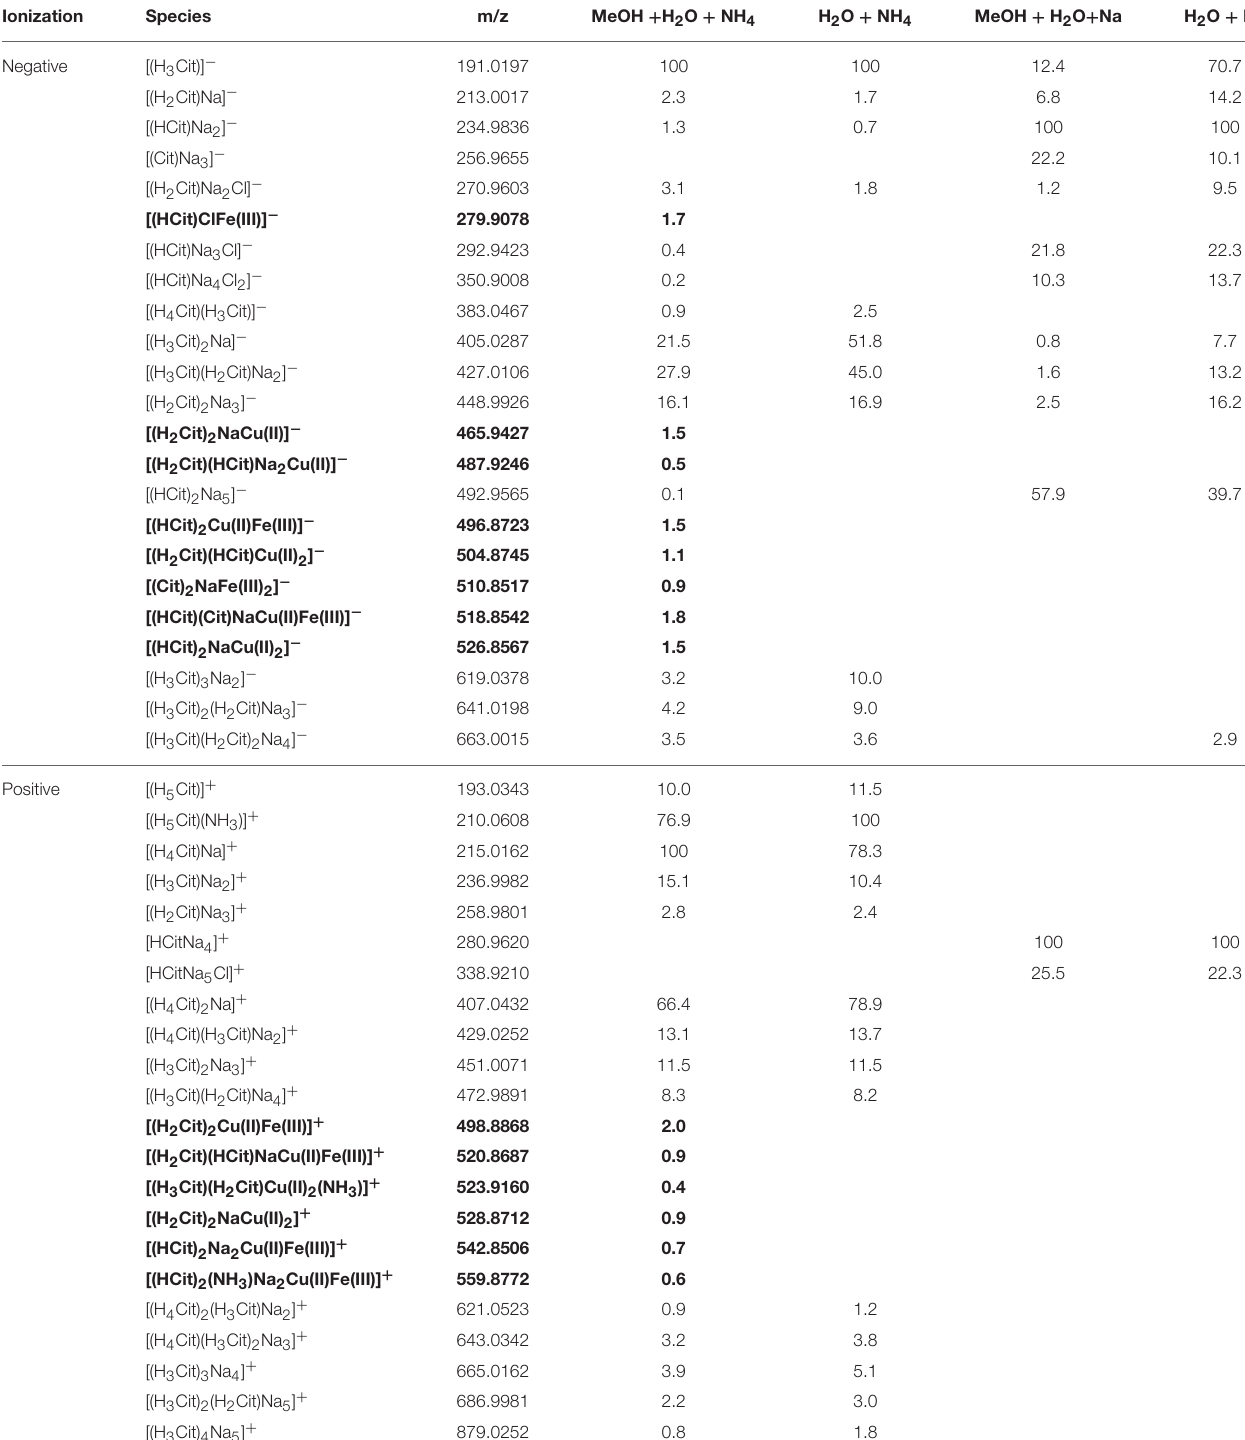
TABLE 2 | Detected citrate and citrate ± Fe ± Cu species (bold) in the four analytical setups at the FT-ICR-MS. Ionization